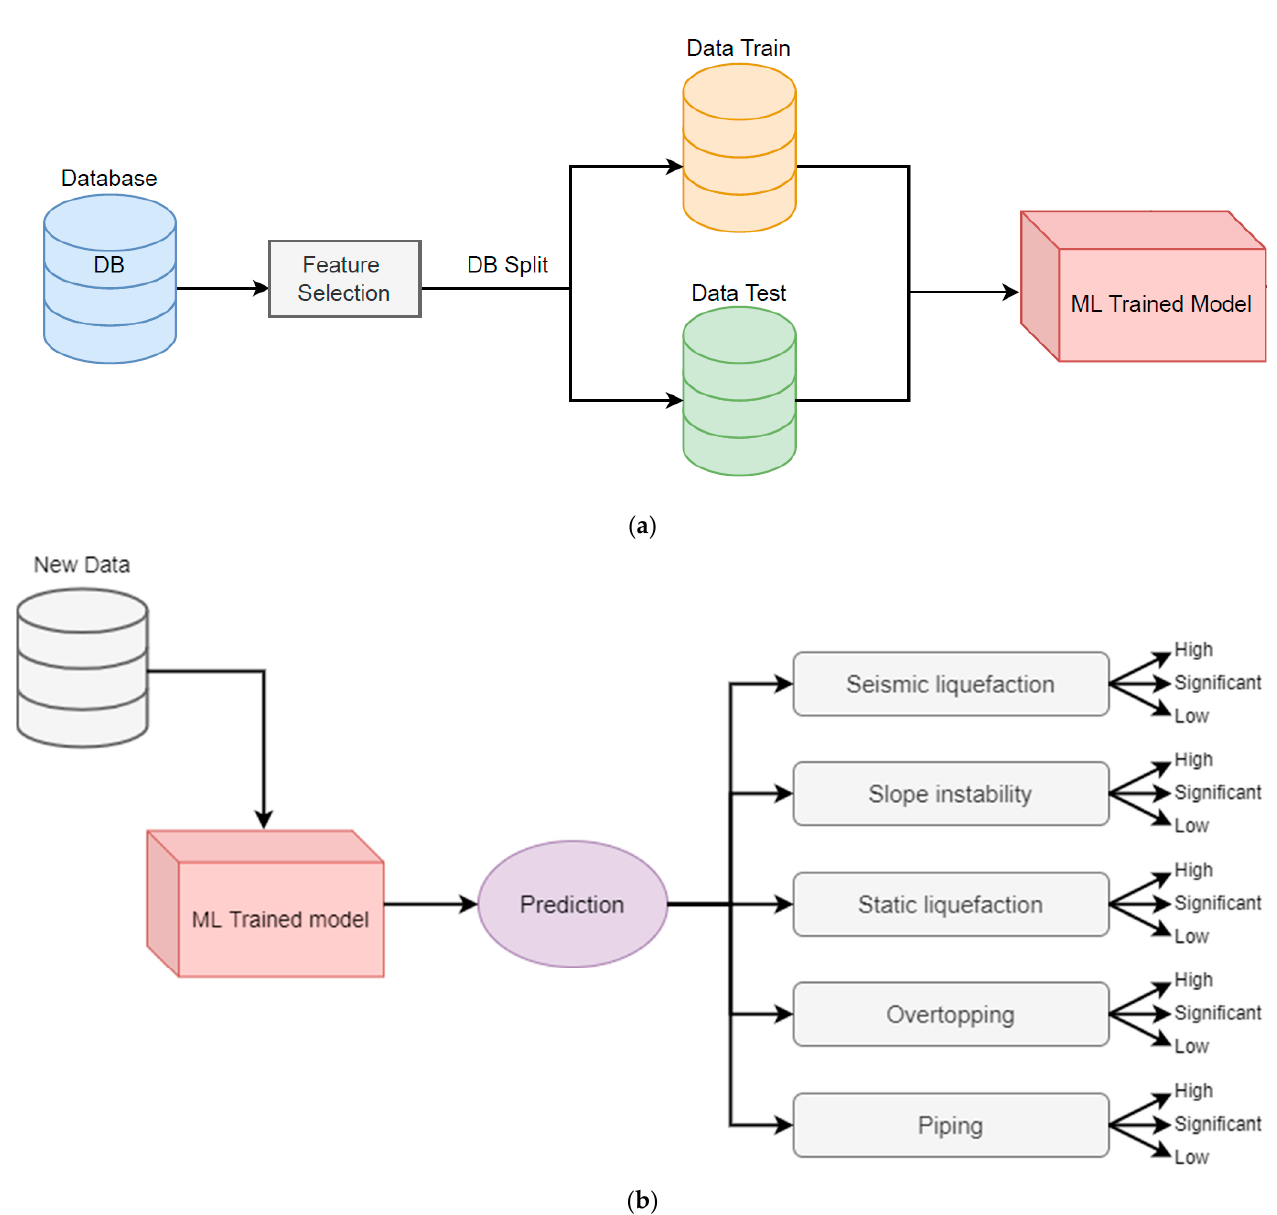
Figure 1. Machine learning algorithm architecture. ( a ) Model training. ( b ) Inference. PS analysis of STD in the closure stage, according to